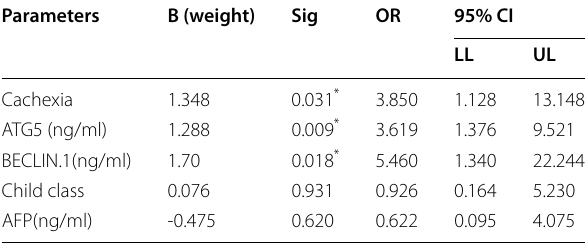
Table 10 Cutoff and scoring points for the different parameters Parameters Cutoff Scoring